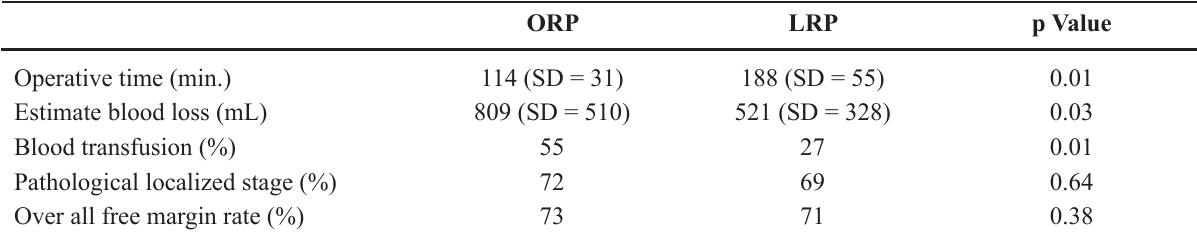
Table 2 – Operative and pathological data in 100 patients of ORP and 100 patients of LRP.